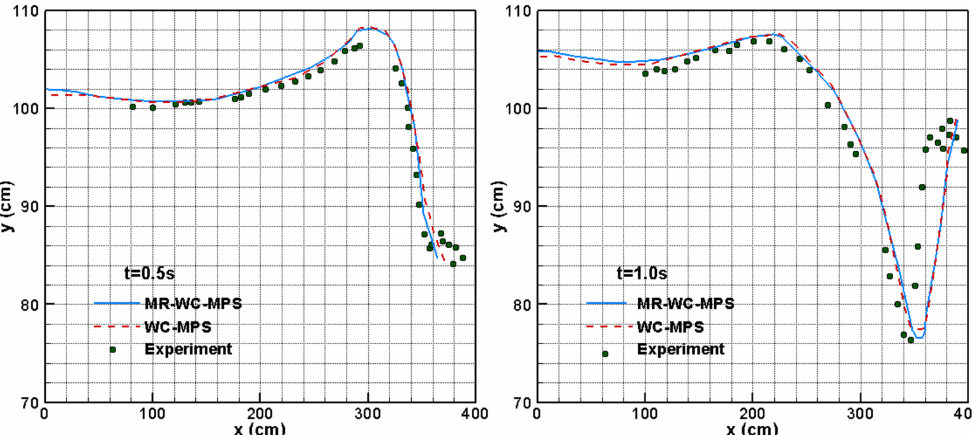
Figure 13. A comparison between the WC-MPS, MR-WC-MPS, and experimental results for the water surface profile in submarine landslide